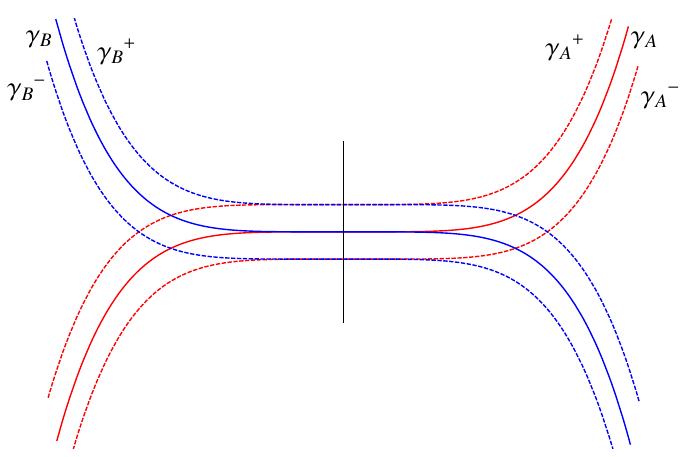
Figure 6 . Strong subadditivity of the regularized entropies of two surfaces (cid:13) A and (cid:13) B with smooth intersection and union. The framings of (cid:13) A and (cid:13) B can be chosen such that they are compatible, i. e., they can be split along the black line in the middle, and reconnect to form the framings of (cid:13) A \ B and (cid:13) A [ B